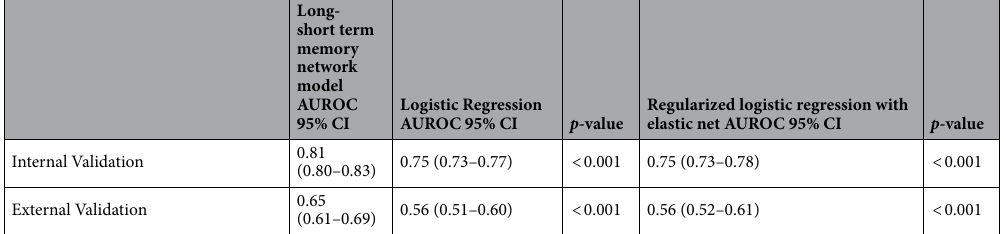
Table 3. Performance of the Long-Short Term Memory (LSTM) Model and the discrete time Logistic Regression (LR) model in Predicting Transfusion of Packed Red Blood Cells by Comparison of Area Under the Receiver Operating Curve (AUROC) for Internal Validation (N = 492) and External Validation (N = 1526).